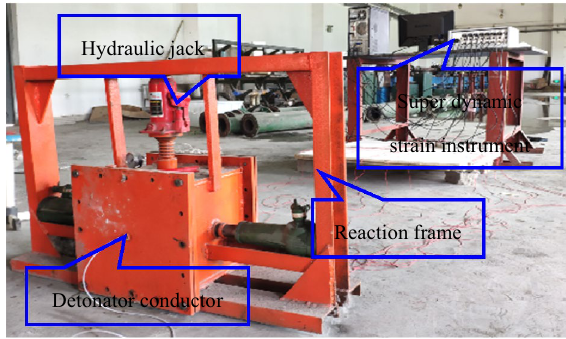
Figure 14. Blasting simulation with the experimental system.